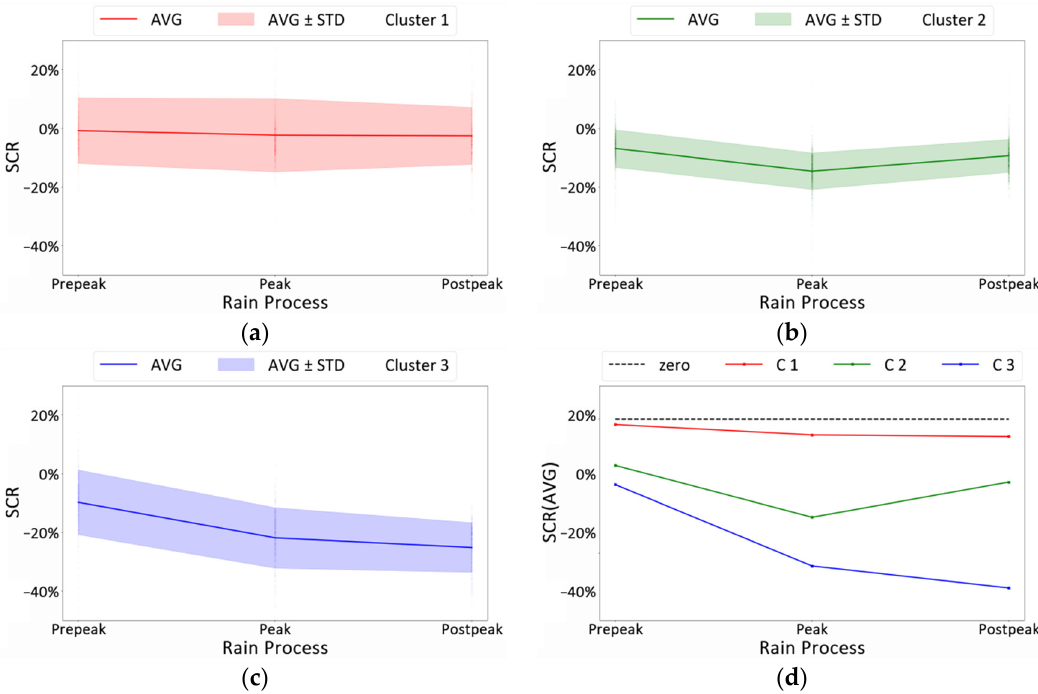
Figure 6. The SCR curves of the links of the three clusters during the heavy rain process. ( a ) SCR of cluster 1; ( b ) SCR of cluster 2; ( c ) SCR of cluster 3; ( d ) SCR of three clusters. Table 3. The mean and standard deviation of the SCR of the links of three clusters. Clusters